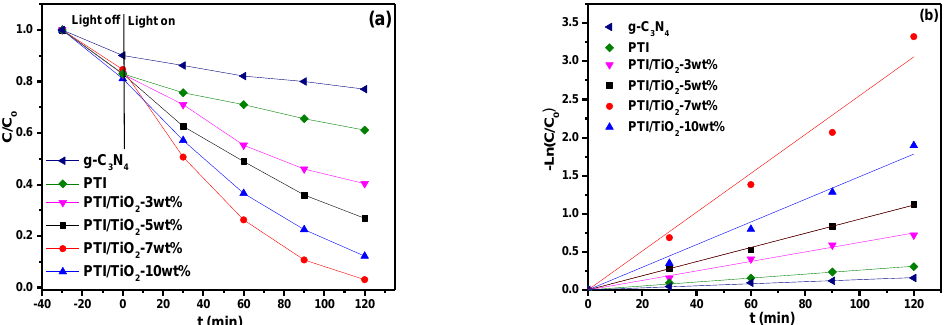
Figure 6. ( a ) Photocatalytic reduction of Cr(VI), ( b ) kinetic plot of the samples under visible light irradiation.